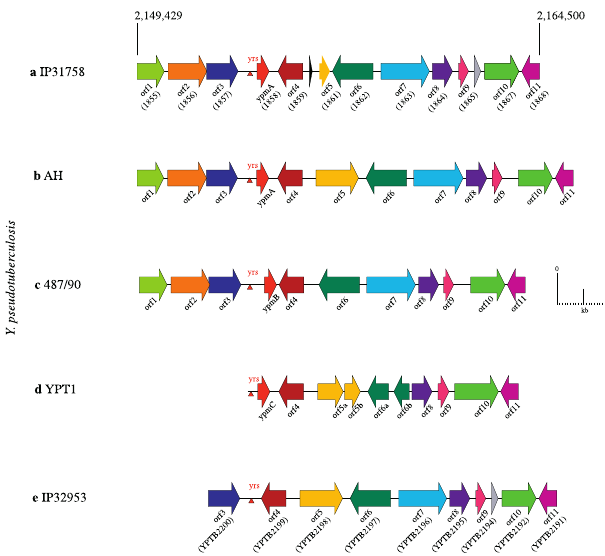
Figure 6. Genomic Architecture of the Superantigenic ypm Locus in Y. pseudotuberculosis (A) The scale in bp indicates the genomic location of the Y. pseudotuberculosis IP31758 ypmA locus from YpsIP31758_1855 to YpsIP31758_1868 integrated downstream of the Yersinia recombination site ( yrs ; red arrow). The Y. pseudotuberculosis IP31758 ypm A locus is composed of 12 genes and is compared to the ypmA , B, and C loci of three superantigenic Y. pseudotuberculosis strains AH (B), 487/90 (C), and YPT1 (D), and to the corresponding region of the non-superantigenic strain Y. pseudotuber- culosis IP32953 (E). CDSs shared between these loci are colored accordingly with the ypm superantigen highlighted in red. The CDS between orf9 and orf10 is not predicted in strains AH, 487/90, and YPT1.